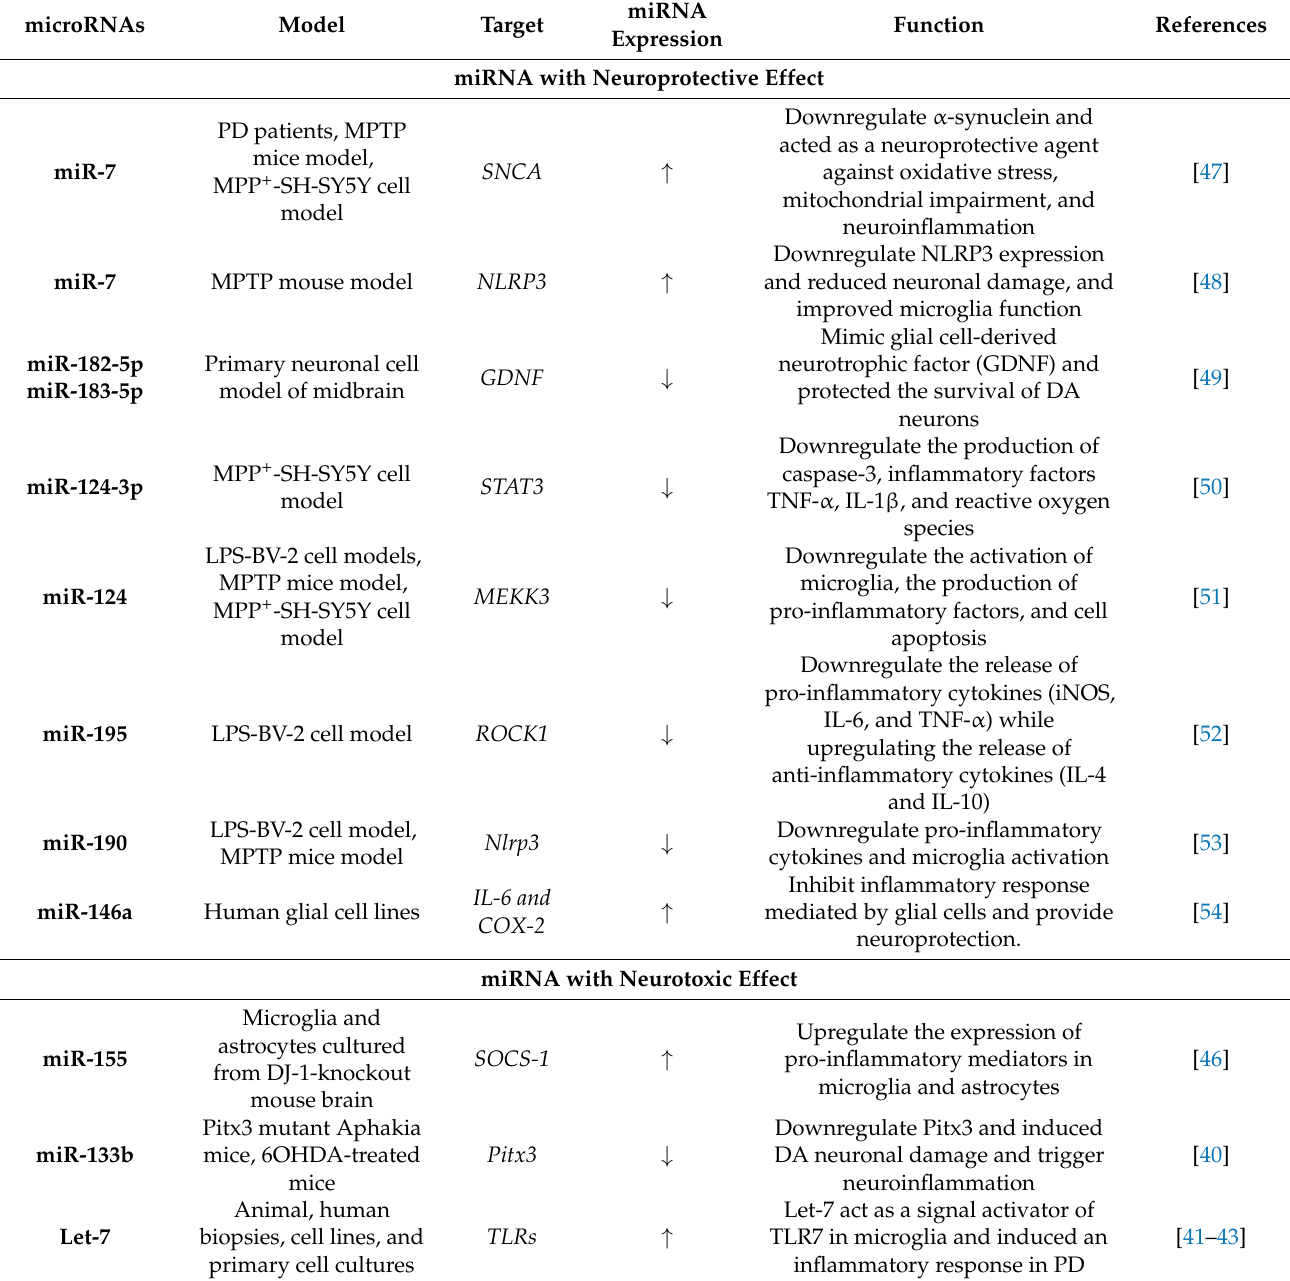
Table 1. MicroRNAs involved in the neuroinflammation in Parkinson’s disease. ↑ shows up-regulated, ↓ shows down-